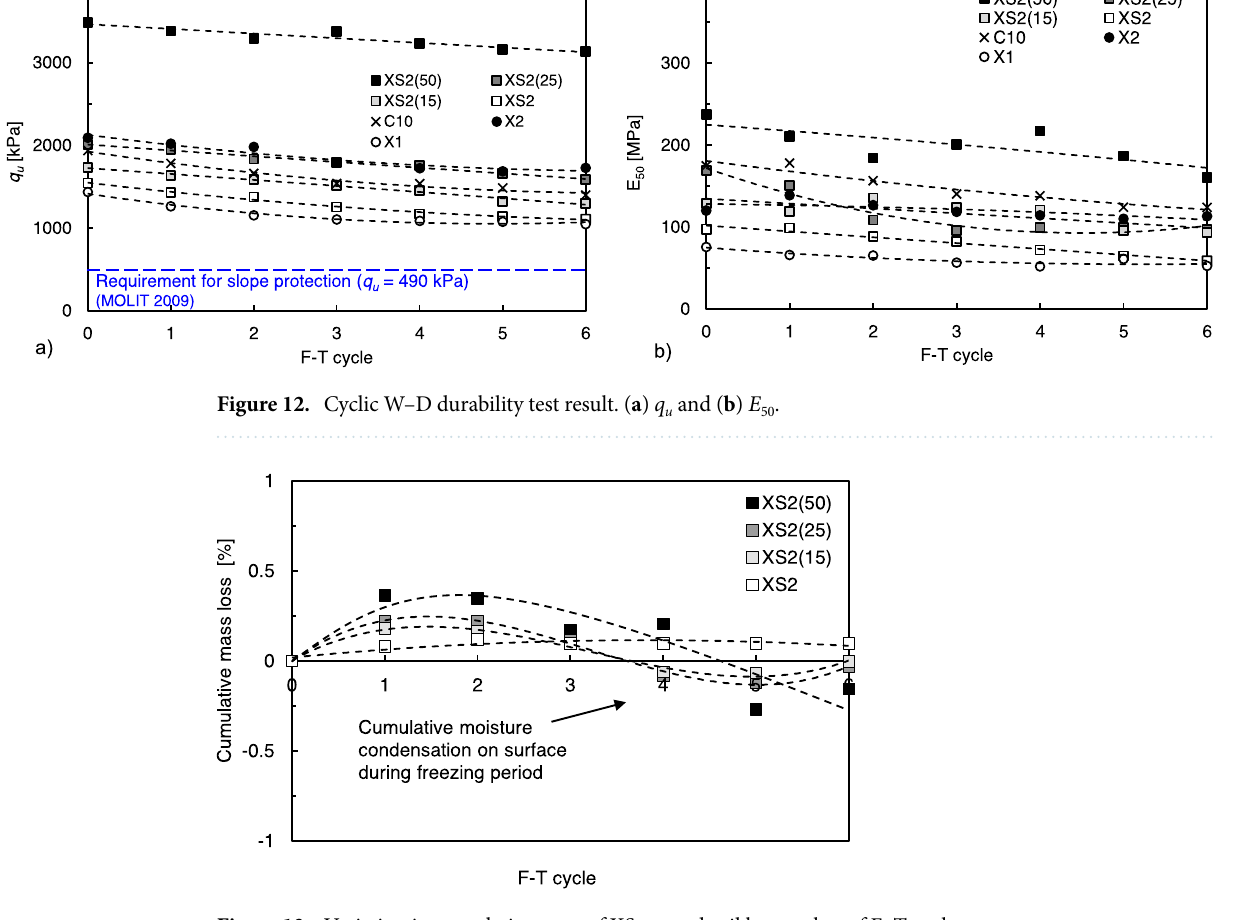
Figure 13. Variation in cumulative mass of XS-treated soil by number of F–T